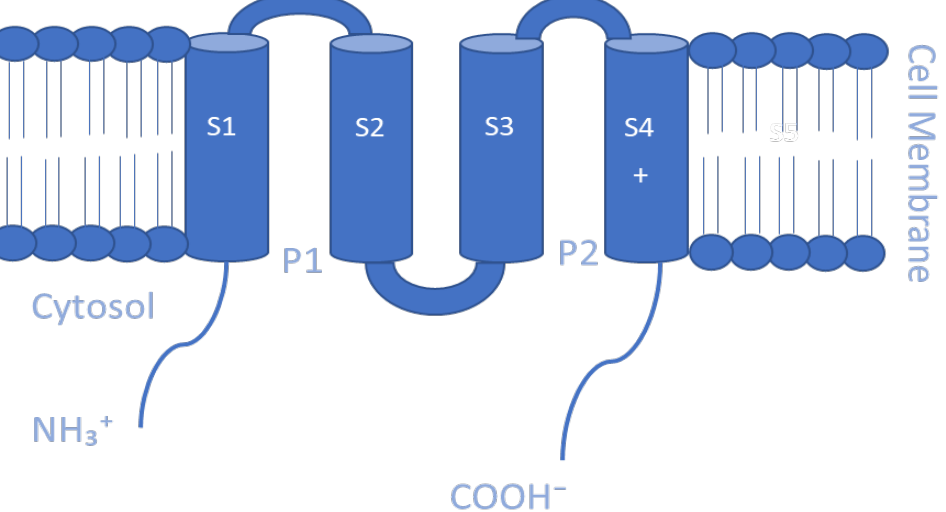
Figure 5. Schematic representation of the transmembrane (TM) topology of K2P channel subunits containing four TM segments with pore region 1 formed by S1 and S2, region 2 by S3 and S4 segments, and N- and C-termini located in the cytosol.